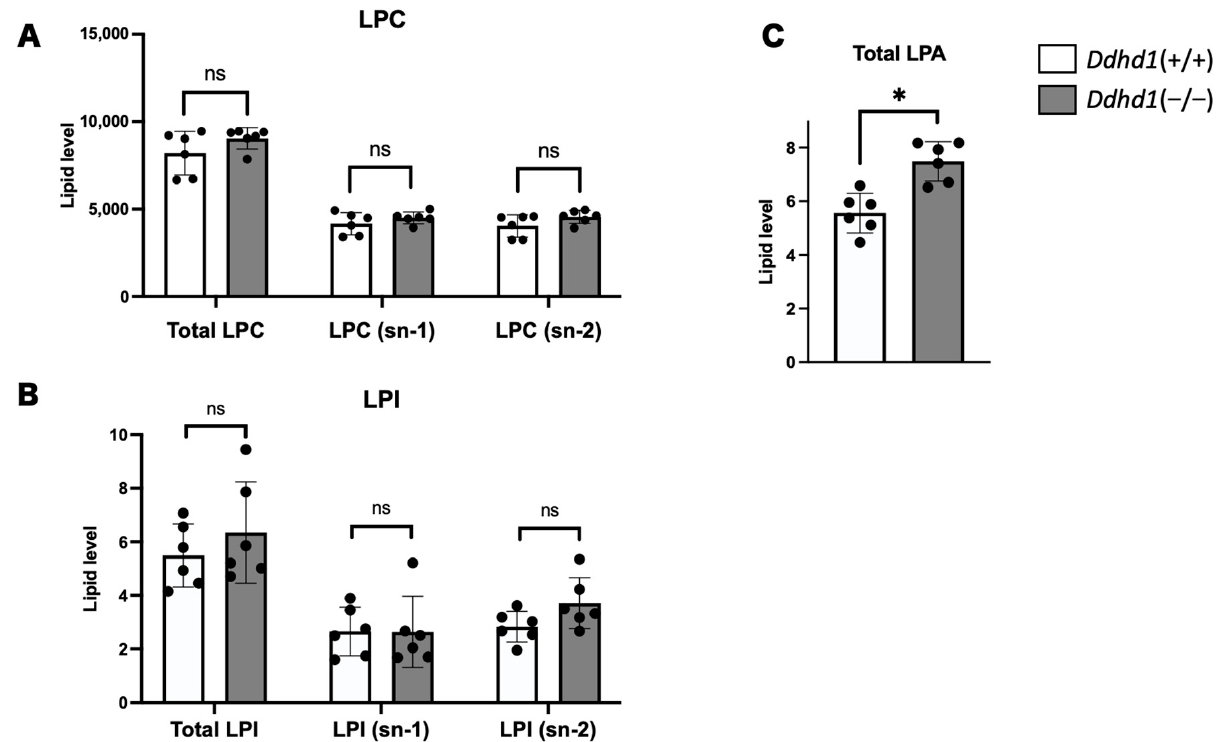
Figure 3. Comparison of total amount of LPC, LPI and LPA. Amount of LPC ( A ), LPI ( B ) and LPA ( C ) in plasma from mice. LPA is shown in only total amount due to the inseparability of sn‑1 and sn‑2 in our analyses. Ddhd1 (+/+) mice and Ddhd1 ( − / − ) mice are shown in opened and filled columns, respectively. The unit of the vertical axis is pmol/mg. Error bars indicate mean ± SD. ns: not